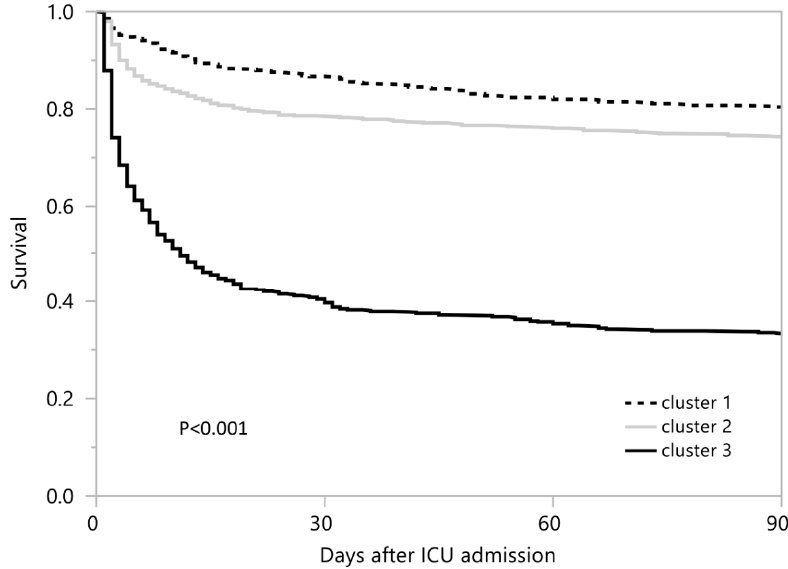
Figure 6. 90-day mortality among different clusters of ICU patients with lactic acidosis.